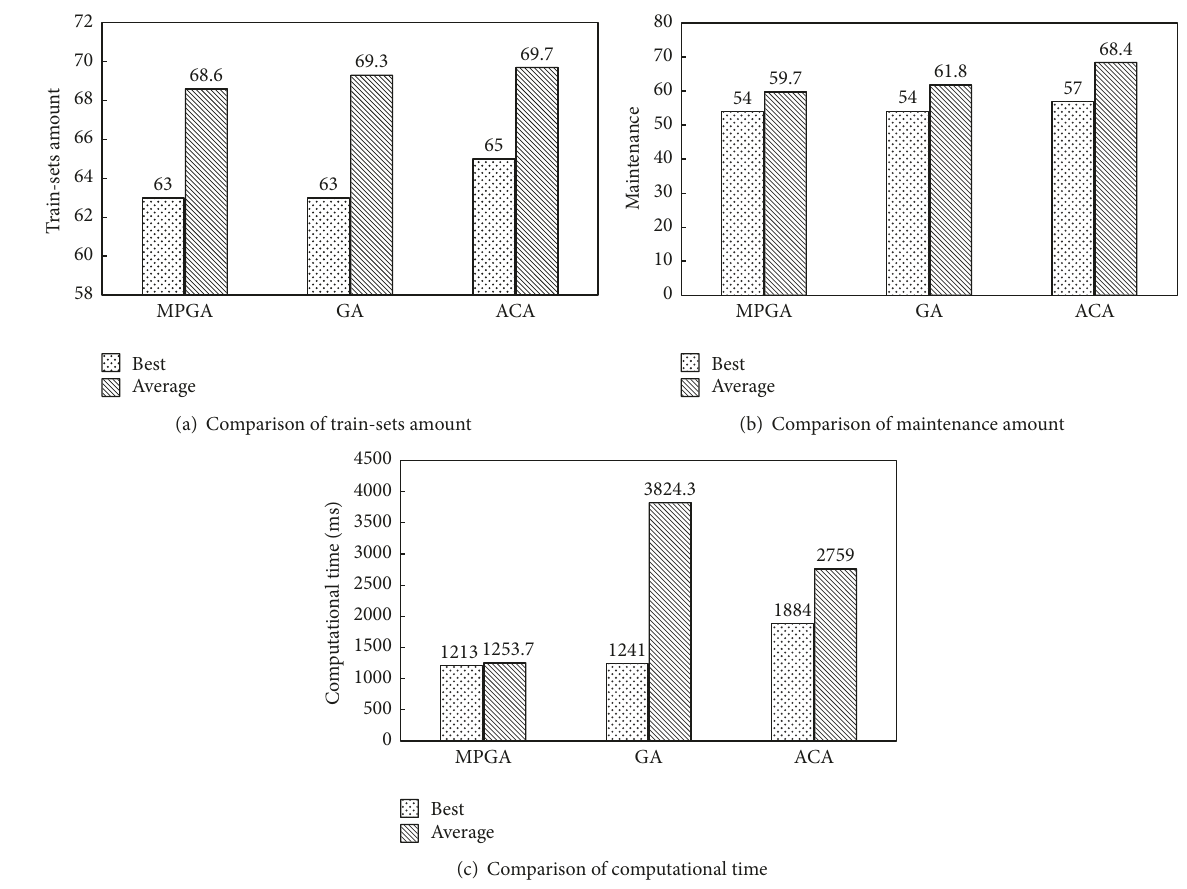
Figure 14: Comparison of three different algorithms. Table 4: Computational results.